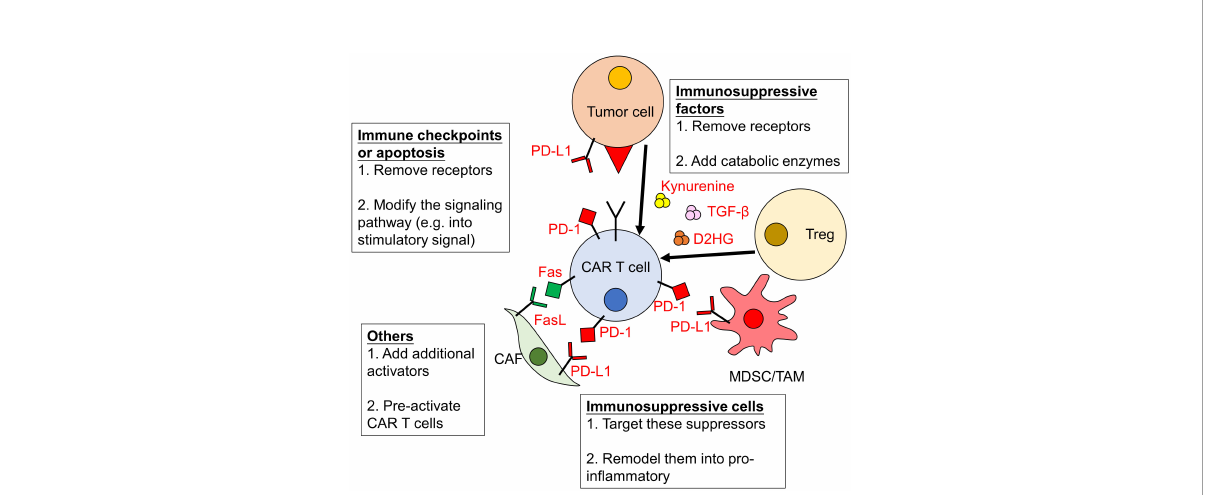
FIGURE 1 Immunosuppressive effects of the TME on CAR-T cells and strategies to overcome them. The activity of CAR-T cells can be severely impaired by the tumor microenvironment (TME). The immunosuppressive effects of the TME are due to increased level of immune checkpoints/inhibitors and immunosuppressive factors/cells. Strategies to overcome them include: (1) removing or modifying related signaling pathways; (2) eliminating or remodeling immunosuppressive cells and (3) enhancing the activation of CAR-T cells. PD-1, Programmed death-1; PD-L1, Programmed death-1 ligand-1; CAF, cancer-associated fi broblasts; MDSC, myeloid-derived suppressor cells; TAM, tumor associated macrophages; Treg, regulatory T cells; TGF- b , transforming growth factor - b ; D2HG,